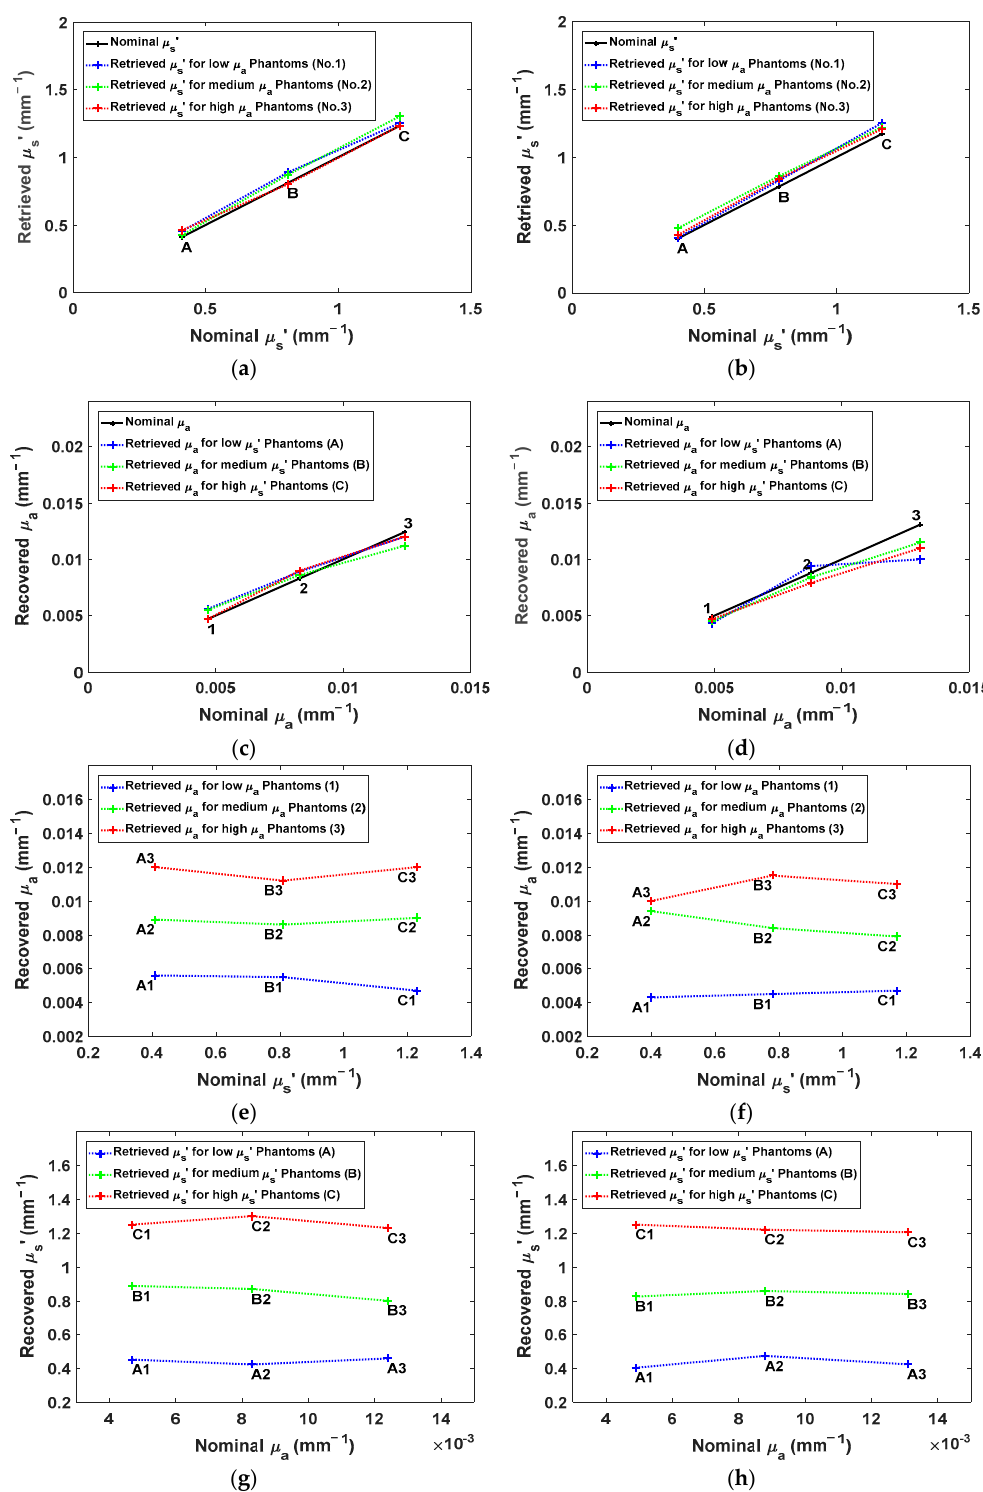
Figure 9. The linearity of the retrieved OP versus the actual OP for nine phantoms at two different wavelengths: ( a ) and ( b ) represent the retrieved µ s ’ against the actual µ s ’ at 685 and 830 nm, respectively; ( c ) and ( d ) represent the retrieved µ a against the actual µ a at 685 and 830 nm, respectively; ( e ) and ( f ) represent the retrieved µ a against the actual µ s ’ at 685 and 830 nm, respectively; and ( g ) and ( h ) represent the retrieved µ s ’ against the actual µ a at 685 nm and 830 nm,